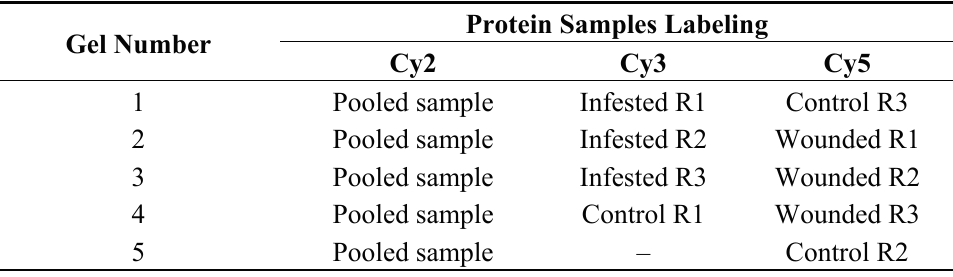
Table 1. Experimental design for 2D-DIGE. Three replicates from each control, infested, and wounded protein samples were labeled and combined for 2D-DIGE.